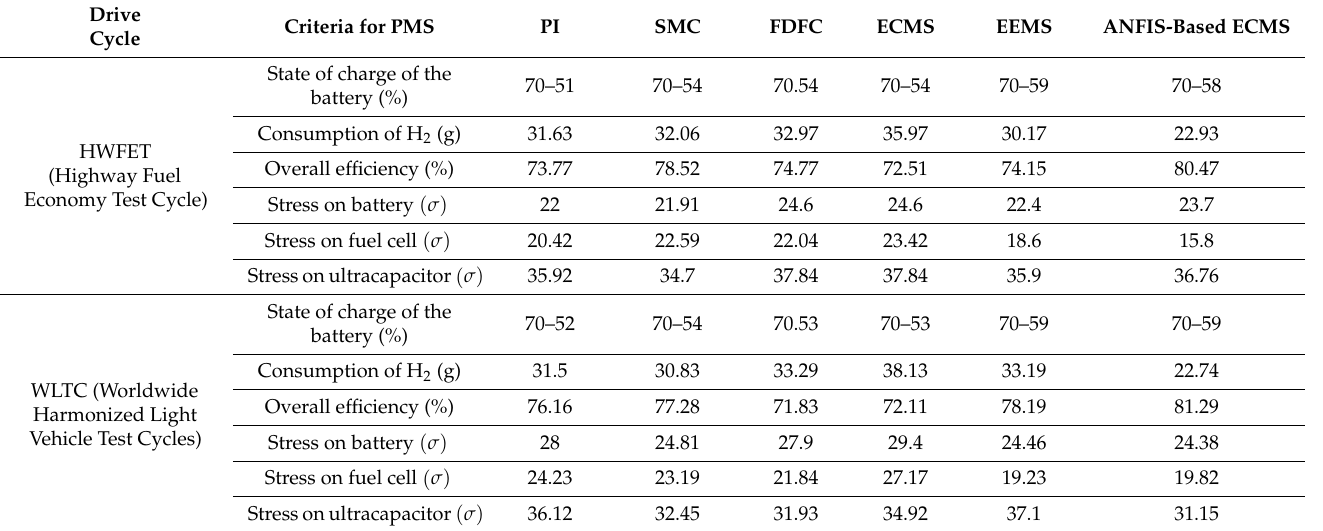
Table 5. Overall performance of each PMS